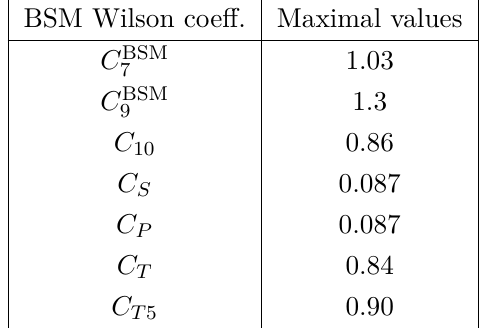
Table 6 . Constraints on the maximal values of the Wilson coefficients from the 90% C.L. limit on the low- q 2 (Reg. I) and high- q 2 (Reg. II) bins of D + → π + µ + µ − branching ratio [38]. BSM Wilson coeff.